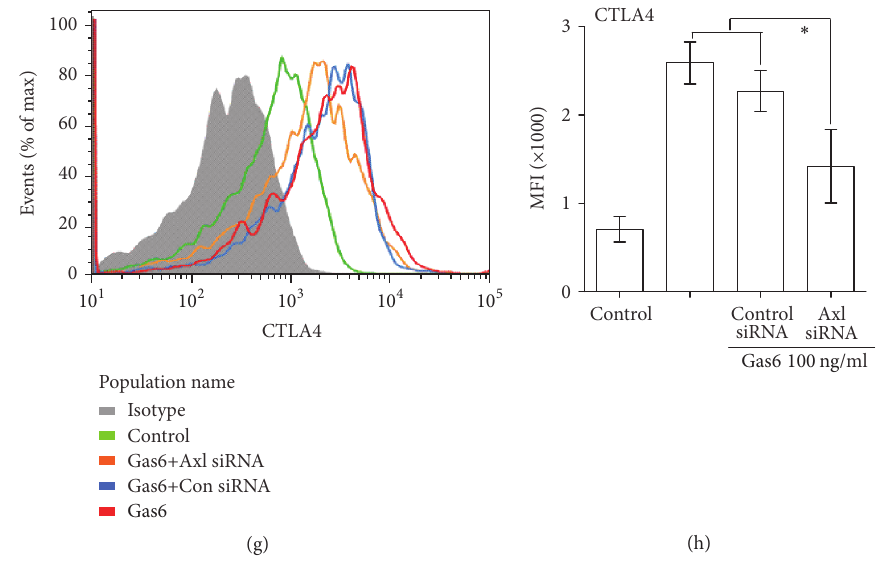
Figure 6: Gas6 modulates the Foxp3 and CTLA4 expression mainly through Axl receptor. (a–d) CD4 + CD25 + Tregs were treated with anti- Axl or anti-Mertk Abs or PBS in the presence of 100 ng/ml rmGas6. After 24 h of incubation, the expression of CTLA-4 and Foxp3 was determined by flow cytometry ( 𝑛 = 4 /group). ∗ 𝑃 < 0.05 compared with the value for the Gas6 group, and # 𝑃 < 0.05 compared with the value for rmGas6+anti-Mertk group. (e–h) The expression of CTLA-4 and Foxp3 in Tregs with or without Axl knockout was determined by flow cytometry. ∗ 𝑃 < 0.05 compared with the value for the Gas6